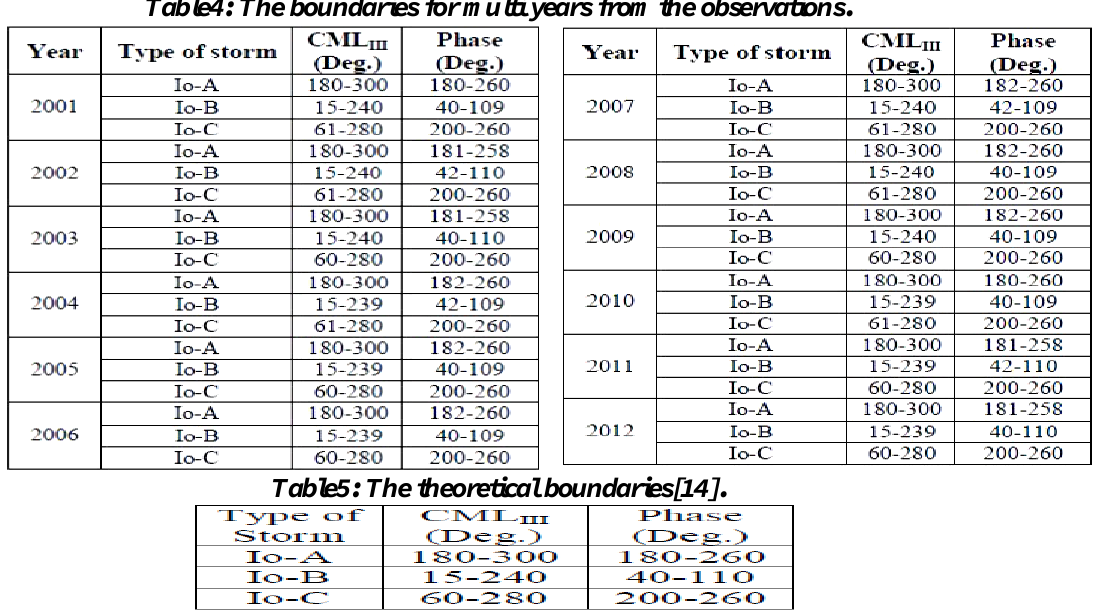
Table5: The theoretical